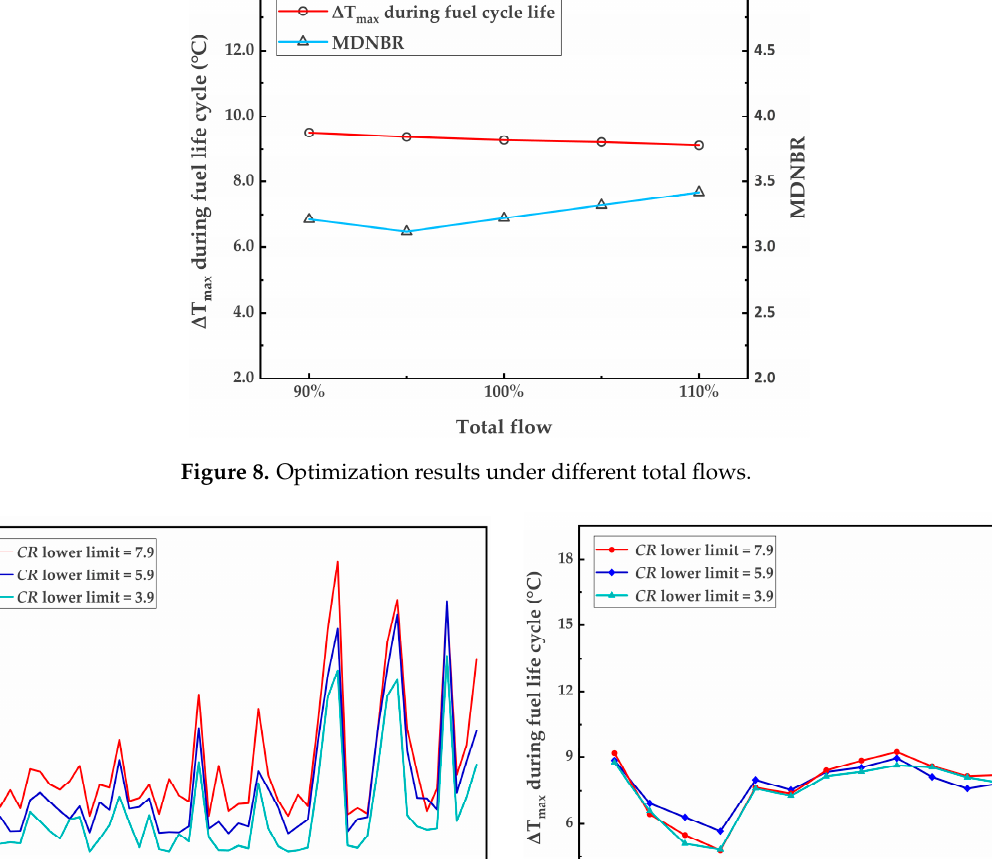
Figure 8. Optimization results under different total flows.